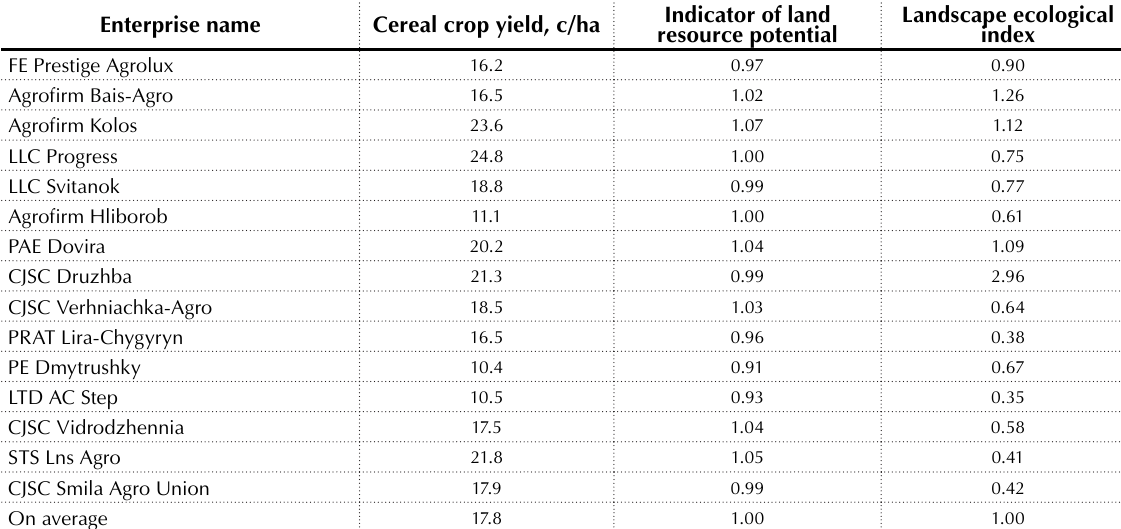
Table 6. Estimation of agricultural production results of some agricultural enterprises in Cherkasy region in